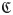
Growth of the mean value of C (left), S (center), and Φ (right) in TreeBASE, as functions of the trees’ numbers of leaves n.